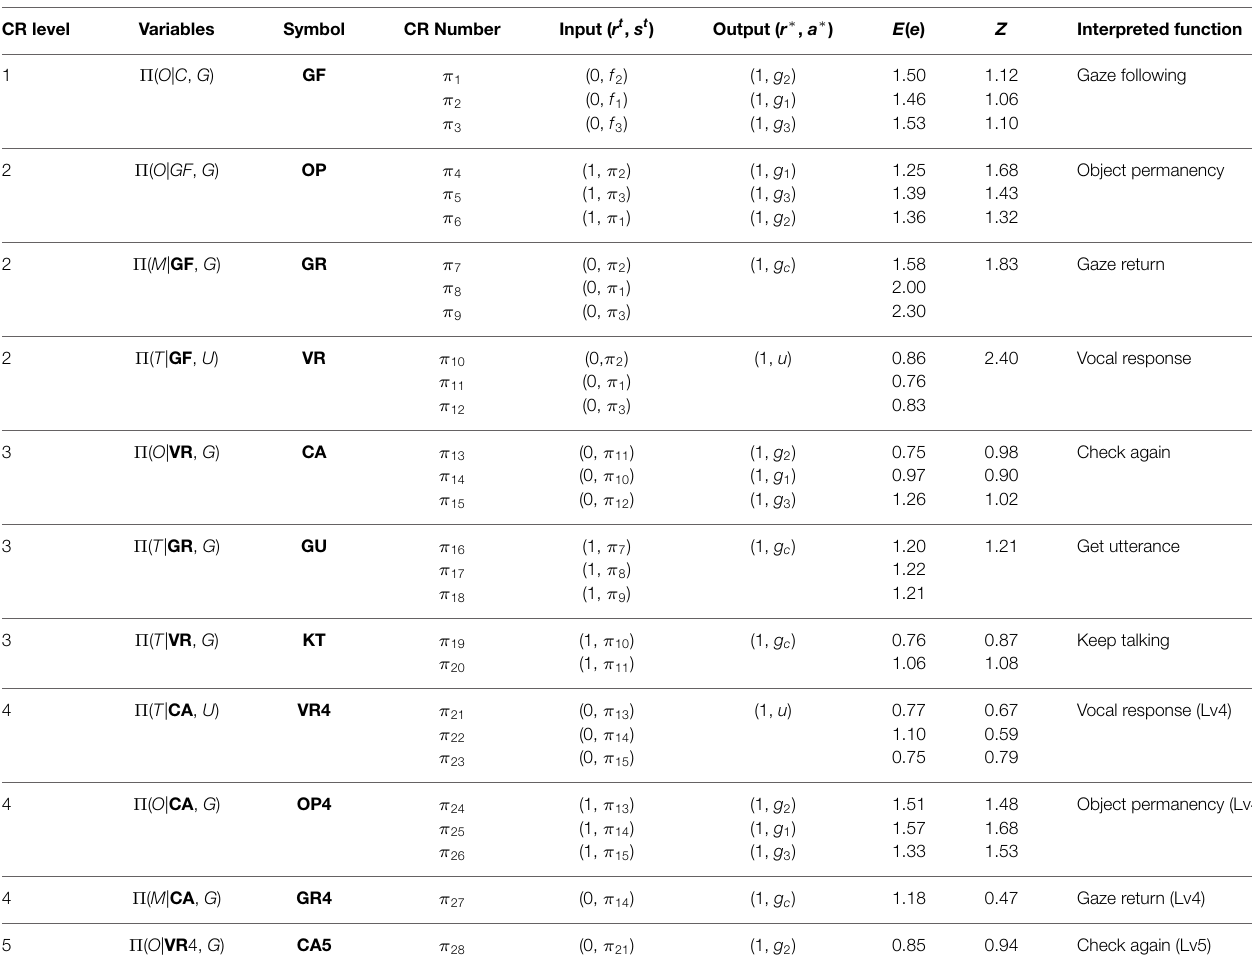
TABLE 3 | Social skills acquired by the robot . CR level